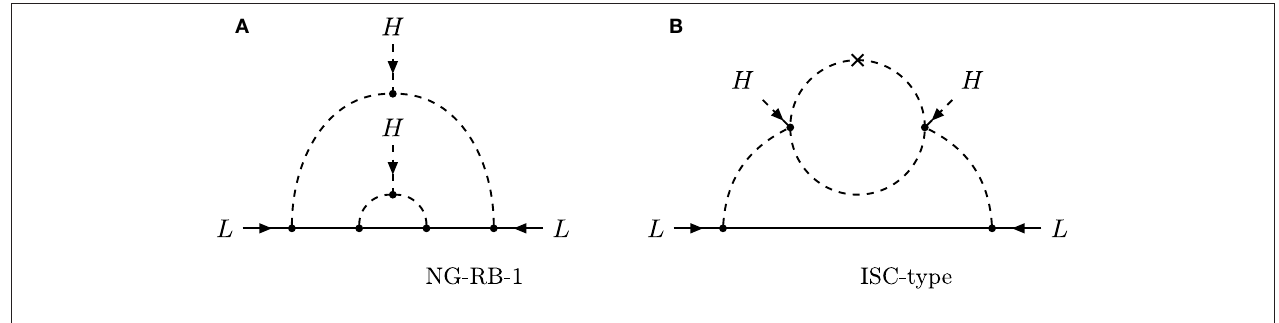
FIGURE 10 | Non-genuine 2-loop